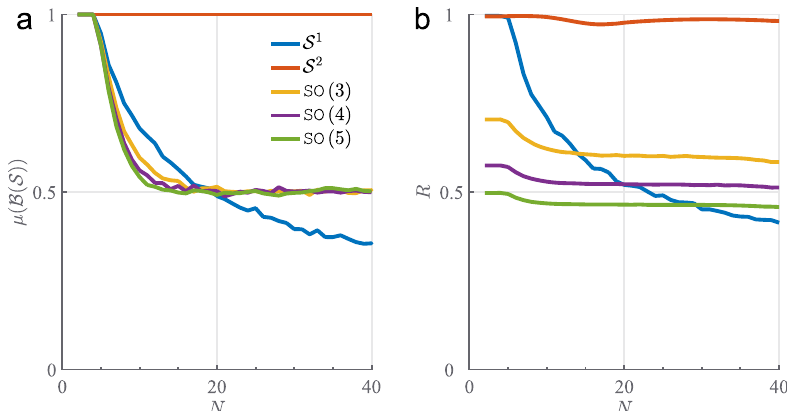
Fig. 5 Indicators of convergence to synchronization and practical synchronization. a Probability measure, μ B ð S Þð Þ 2 ½ 0 ; 1 (cid:3) , of the basin of attraction B ð S Þ of the synchronization manifold S given by (Eq. 19) on the spheres S 1 ; S 2 and Stiefel manifold St ( n − 1, n ) ≅ SO ( n ) (special orthogonal group) for n ∈ {3, 4, 5} where the network is given by the graph C fi ned by Eq. (7) and the number of agents N ∈ {2, … , 40}. The probability measure μ ð B Þ is N de calculated by Monte Carlo integration over M = 10 4 system evolutions for each point. b Average value of the order parameter R given by Eq. (15); each point corresponds to 10 4 simulations. The graph is the cycle graph C N given by (7). We set the coupling parameters between neighboring agents i and j to k ij = 1. The ( s , t )-elements of the frequency matrix ð Ω N ð 1 ; 1 = N Þ 2 if s < t and ð Ω N ð(cid:2) 1 ; 1 = N 2 Þ if s > t , where N ð(cid:4) ; (cid:4)Þ denotes a normal distribution. i Þ st 2 i Þ st 2